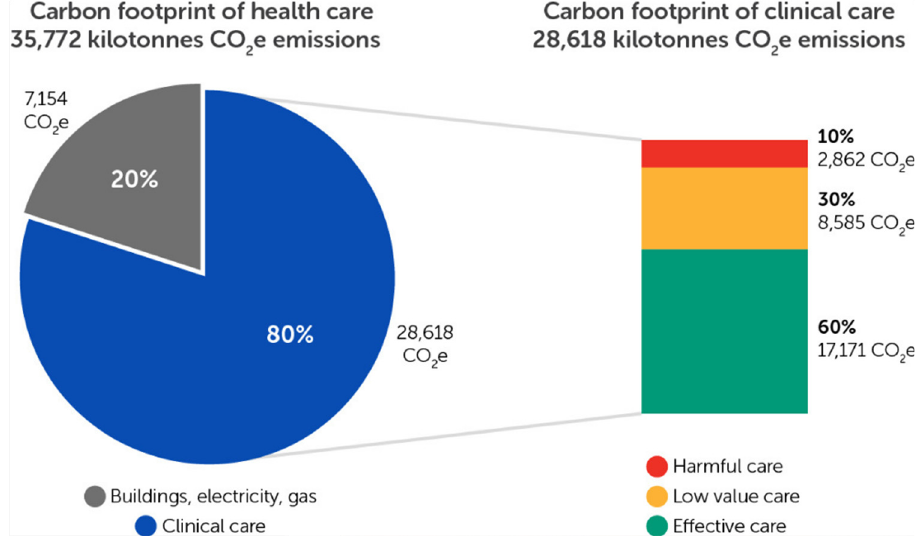
Figure 3. The carbon footprint of Australian health care and the share of its carbon emissions at- tributable to harmful, low value and effective care. (CO2e—Carbon Dioxide Equivalent). Source: [85] originally from [5]).